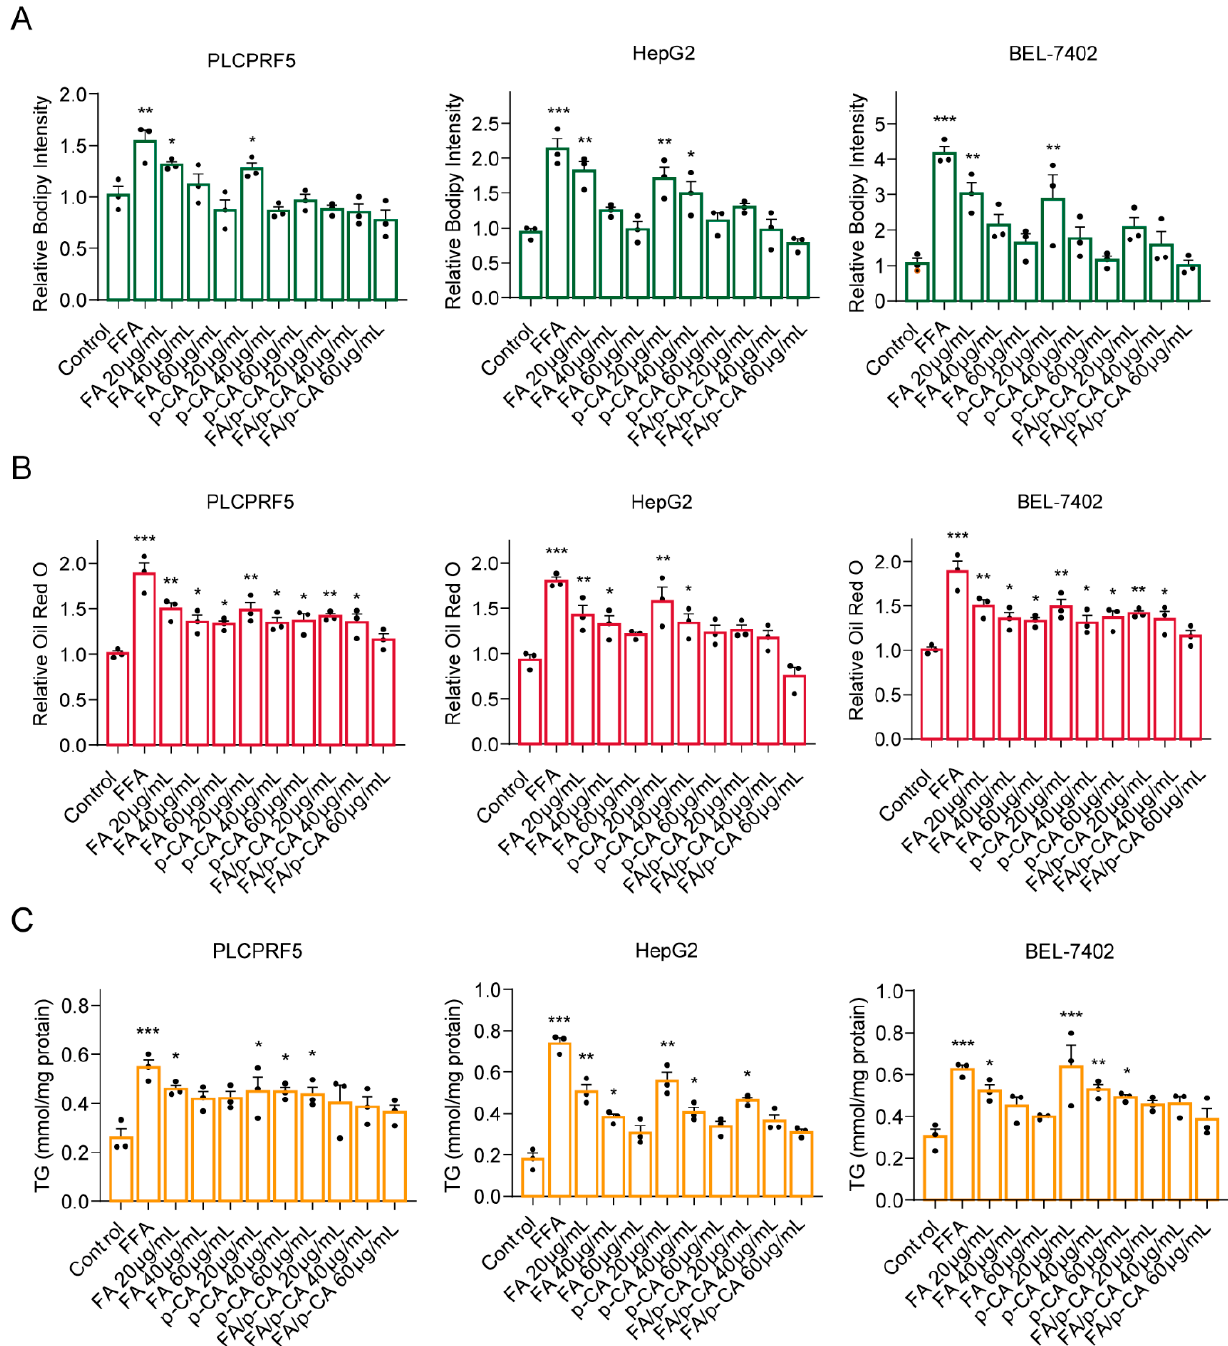
Figure 2. FA/p-CA treatment suppresses FFA-induced lipid accumulation in vitro. ( A , B ) After stimulation with or without FFA, PLCPRF5, HepG2, and BEL-7402 cells were exposed to FA, p-CA, and FA/p-CA, respectively, and then stained with BODIPY ( A ) and Oil Red O ( B ) to detect cellular lipid accumulation. The content ratio of p-CA and FA in the FA/p-CA was 1:1.13. ( C ) TG content in PLCPRF5, HepG2, and BEL-7402 cells of each group treated with FA, p-CA, and FA/p-CA. The data are presented as the mean ± SD. Compared to control, * p < 0.05, ** p < 0.01, *** p < 0.001.